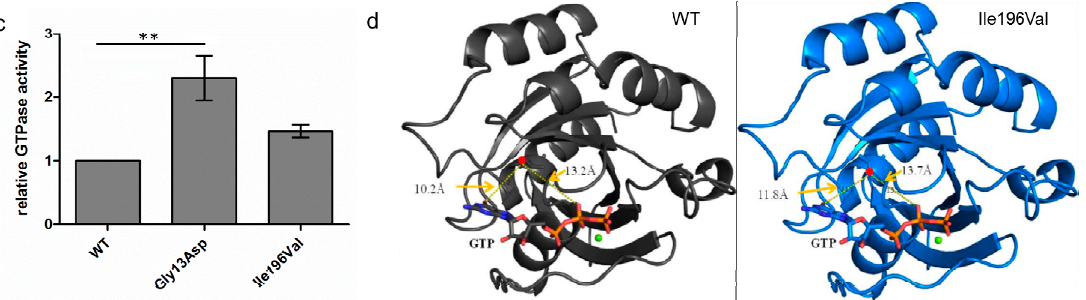
Figure 2. RAB12 and functionally investigated variants. ( a ) Schematic view of the RAB12 protein with the identified mutations p.Gly13Asp and p.Ile196Val in MD patients (red arrows), the guanosine diphosphate/guanosine triphosphate (GDP/GTP)-binding sites (red), the predicted effector region (blue), and the posttranslational modifications on amino acid positions 1 (N-acetylation), 21, 25, 106 (phosphorylations), 243, and 244 (geranylgeranylations) are indicated. RefSeq: NM_001025300.2, NP_001020471; ( b ) The Glycine at position 13 (left panel, red) and the Isoleucine at position 196 (right panel, red) are conserved across different species; ( c ) Proteins of transfected SH-SY5Y cells were incubated with GTP for 1 h and PO 43 − production was measured. GTPase activity of mutant RAB12 expressing cells was normalized for GTPase activity of wild-type (WT) RAB12 expressing cells. The bars indicate the means ± standard error of mean, One-way analysis of variance (ANOVA) with Bonferroni’s post-hoc test. ** p < 0.01, n = 4; ( d ) Homology model of active/GTP-bound RAB12 in ribbon representation. WT is presented in black (left model) and p.Ile196Val in blue (right model). Magnesium ions are shown as green spheres, amino acid residue 196 is marked by red points, and GTP is indicated by sticks. The figures were generated with PyMOL (PyMOL Molecular Graphics System, Version 1.7.0 Schrödinger, LLC, New York, NY, USA).